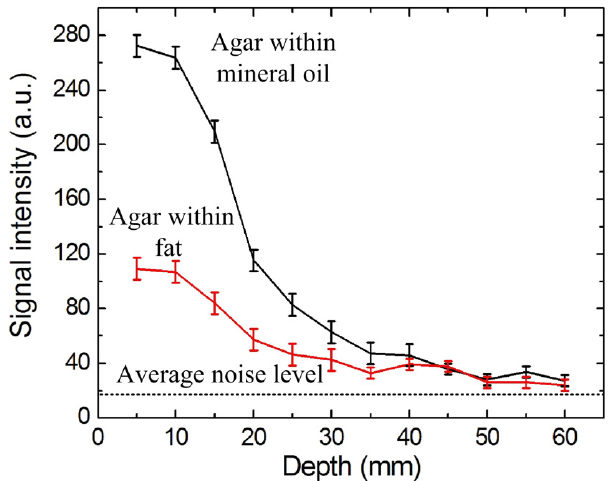
Fig. 6. Relationship between signal intensity and depth in mineral oil and